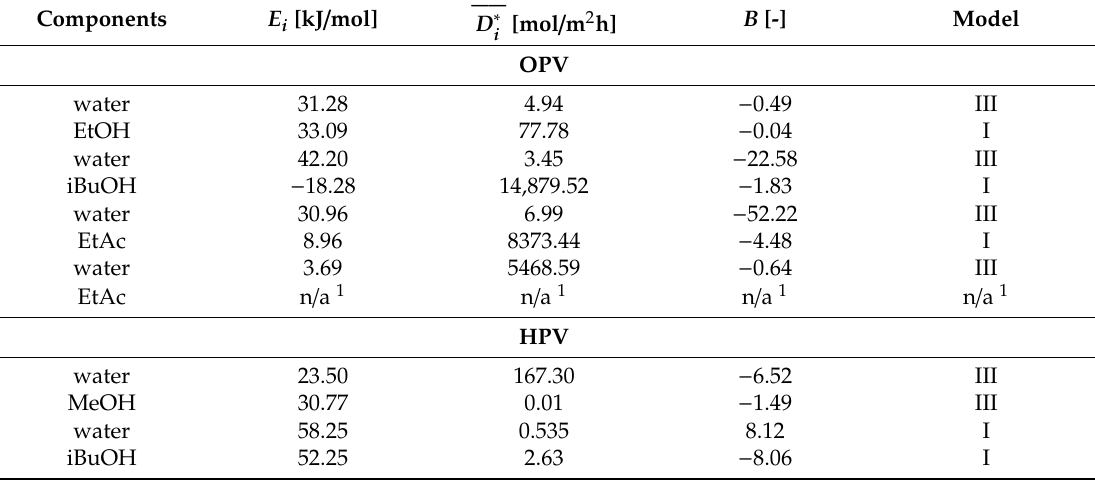
Table 3. Estimated function parameters in case of the best model for each